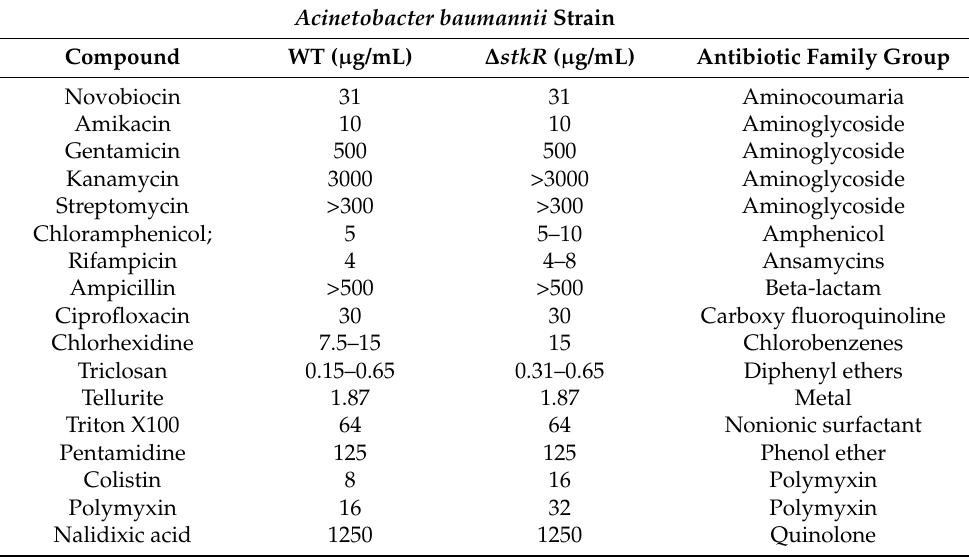
Table 3. Antimicrobial resistance profile of the Acinetobacter baumannii 04117201 and ∆ stkR